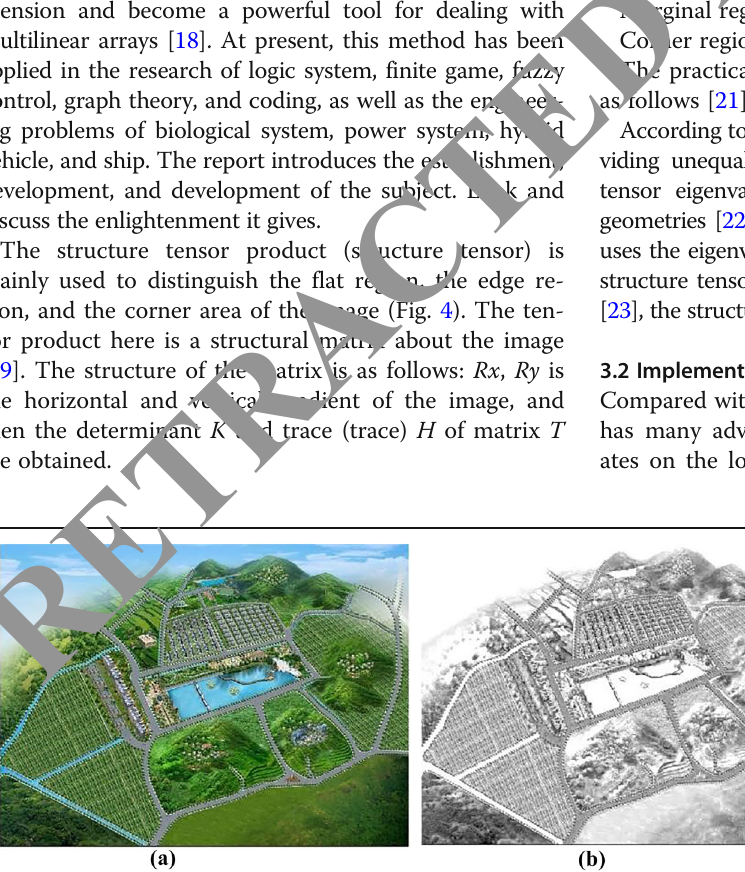
Fig. 3 Gradient display of different channel images. a Any band gray image. b Any two different band gradient detection edge. c Structural tensor product unified edge detection